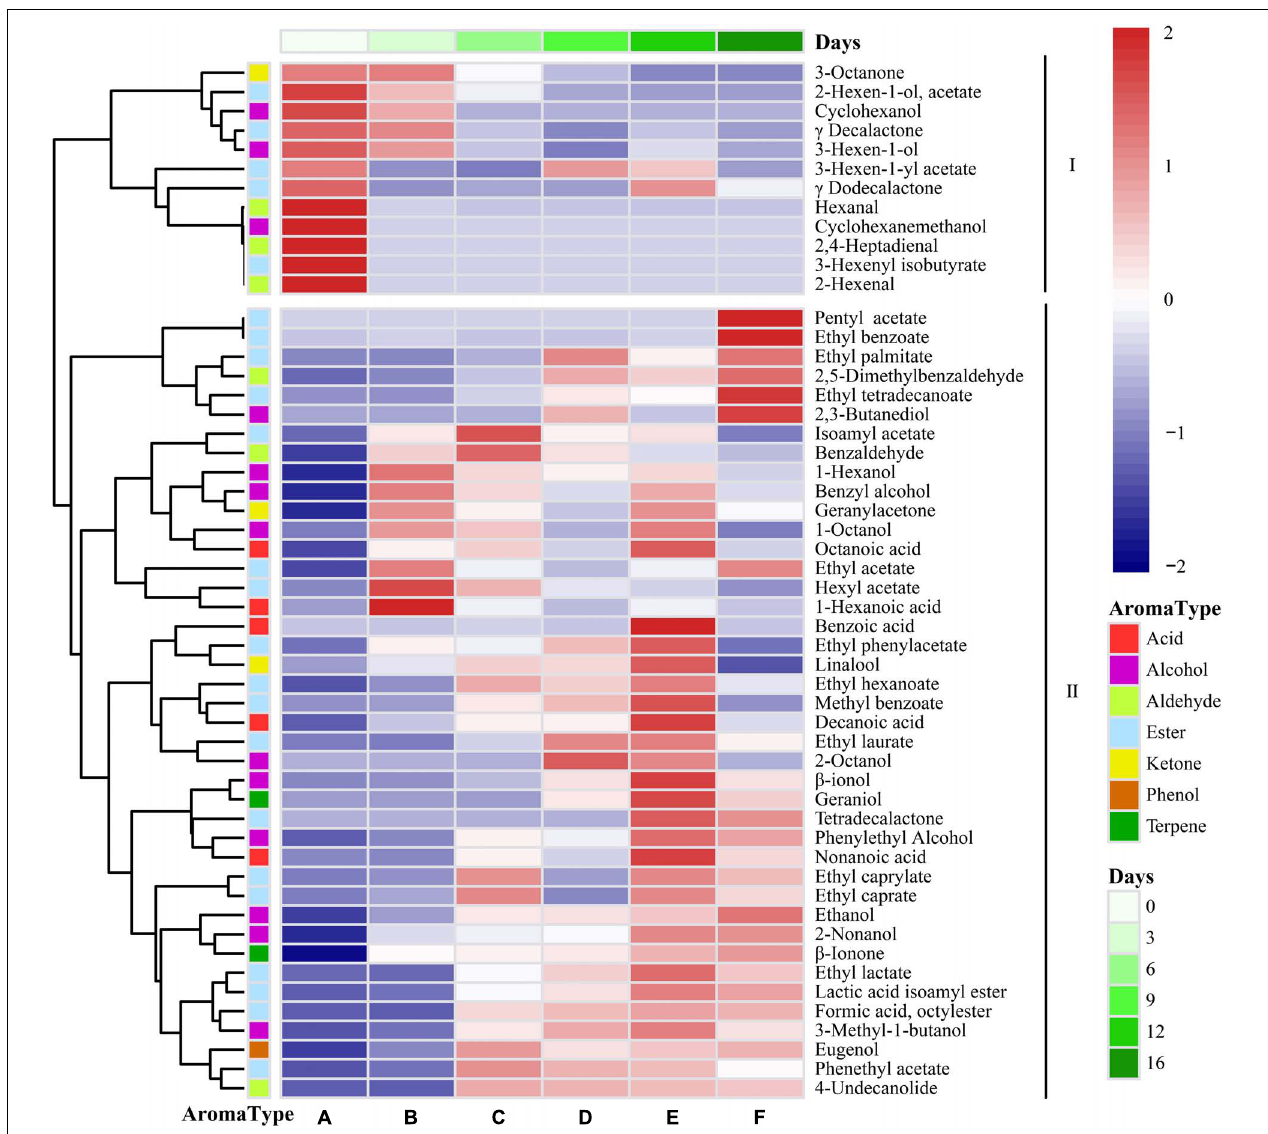
FIGURE 6 | Heatmap cluster analysis of the volatile components identified during fermentation. The colors correspond to normalized mean levels, from low (blue) to high (red); the scale is shown at the top. A, B, C, D, E, and F) Represent samples collected on fermentations days 0, 3, 6, 9, 12, and 16,